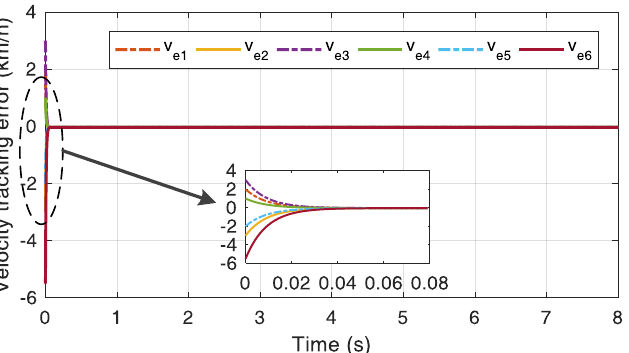
Figure 5. Velocity tracking error curve of each carriage with the proposed consensus braking controller in case 1.